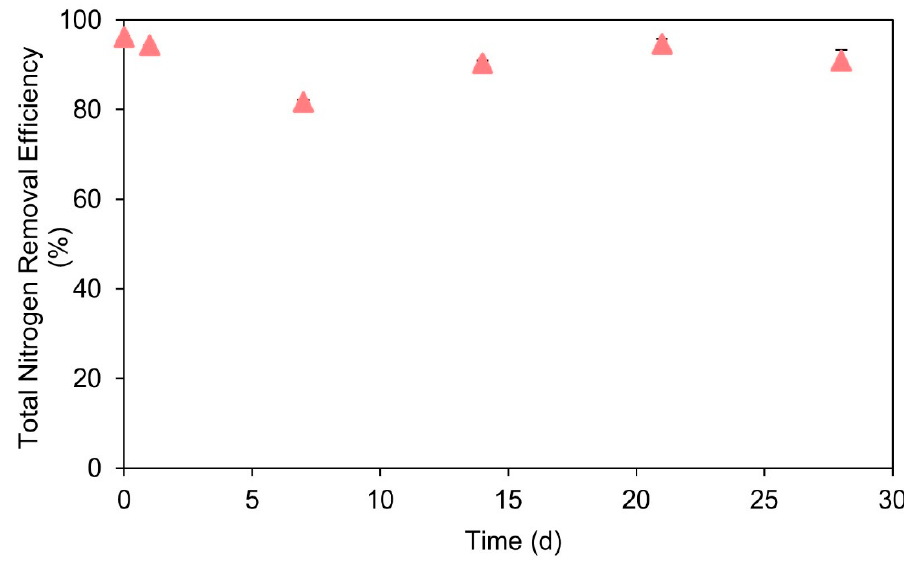
Figure 4. Nitrogen removal efficiency during long-term caffeine dosing.